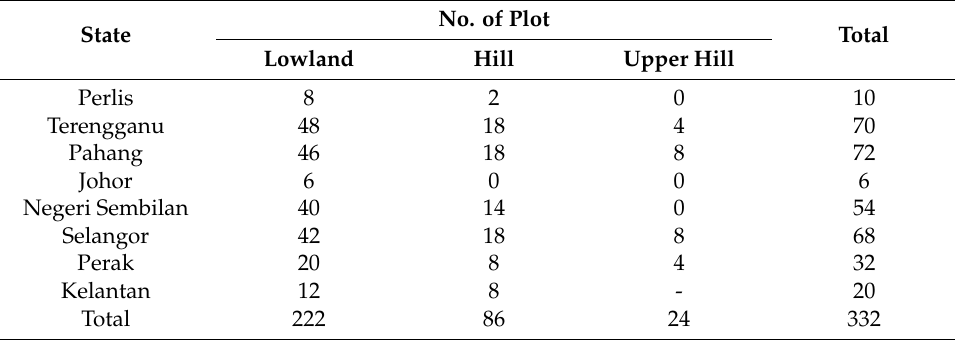
Table 3. Summary of distribution of sample plots within the study area.